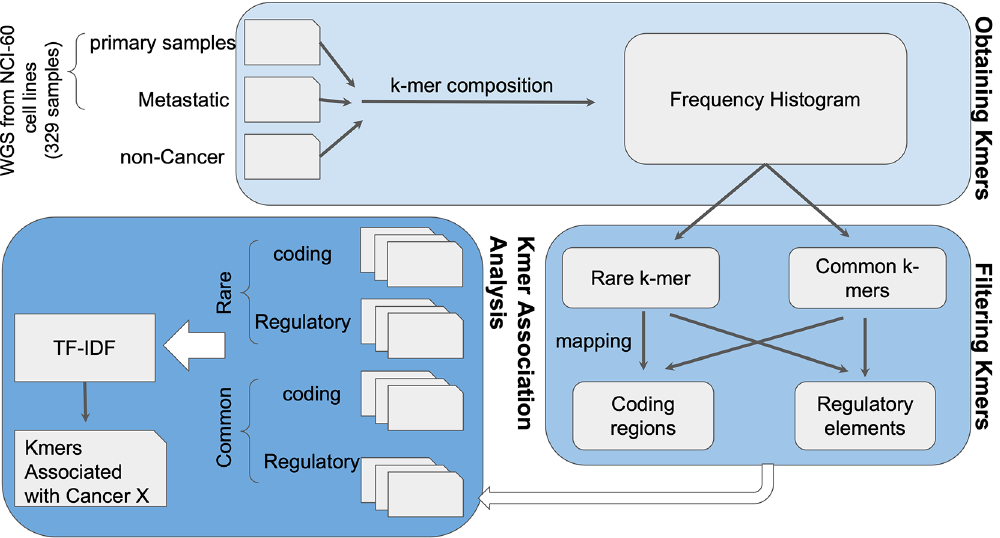
Figure 6. K-var workflow. The k -mer composition of whole-genome sequencing (WGS) sequencing data from cases and controls is obtained using Jellyfish. Rare and common k -mers are identified based on their frequency across samples, and mapped to a reference genome to assess their putative functional impact. Selected k- mers are then compared between cases and controls using term frequency-inverse document frequency (TF-IDF)